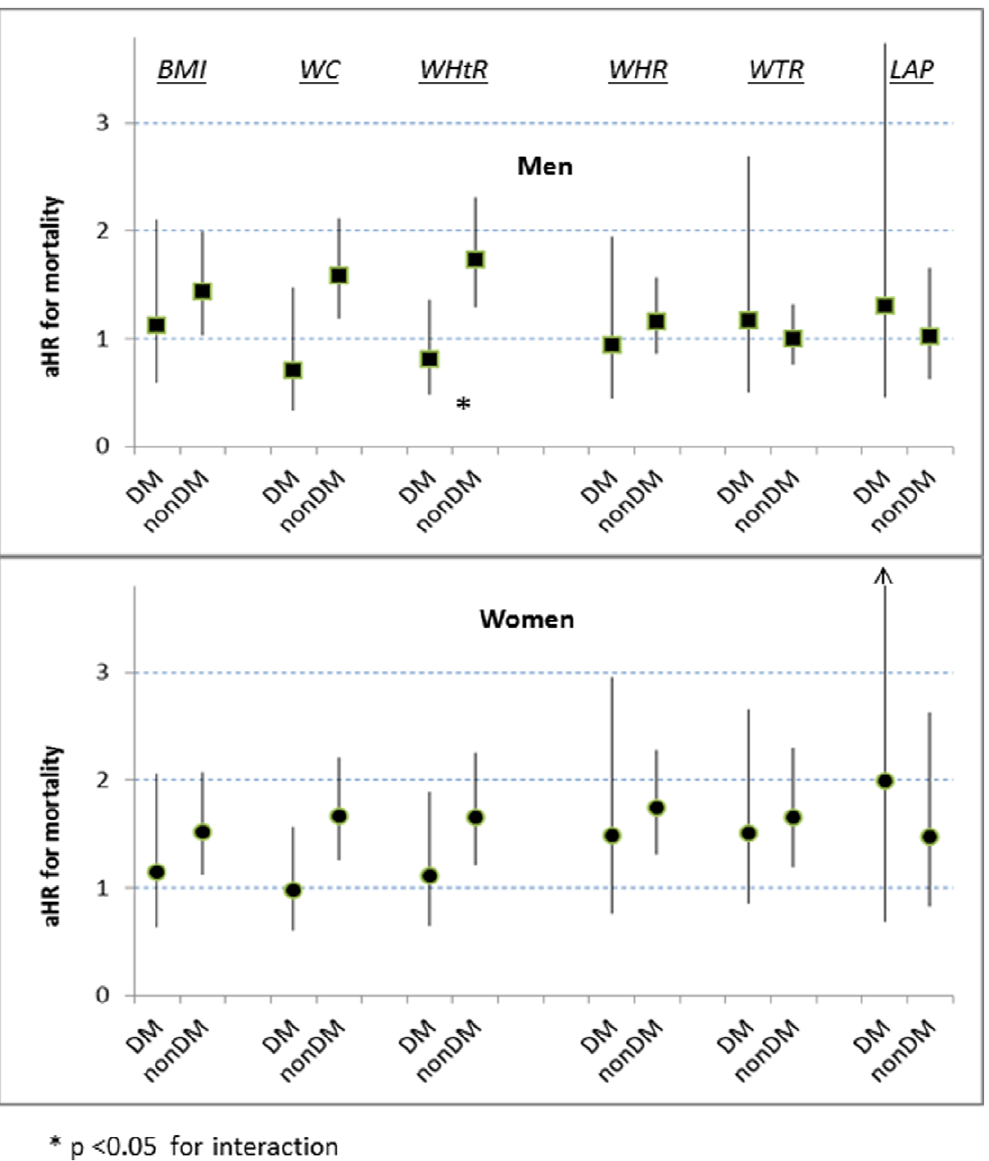
Figure 5. Interactions with baseline diabetes for mortality risk at p75, by 6 adiposity indicators. (aHR=multiply adjusted hazard ratio).